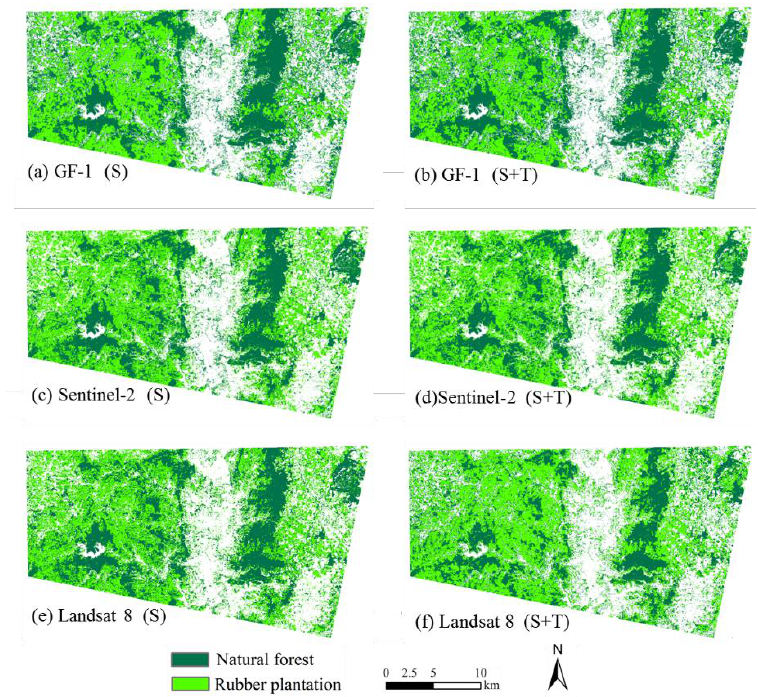
Figure 6. Random forest (RF) classification results based on the spectral features only ( a , c , e ) and the spectral + textural features ( b , d , f ).